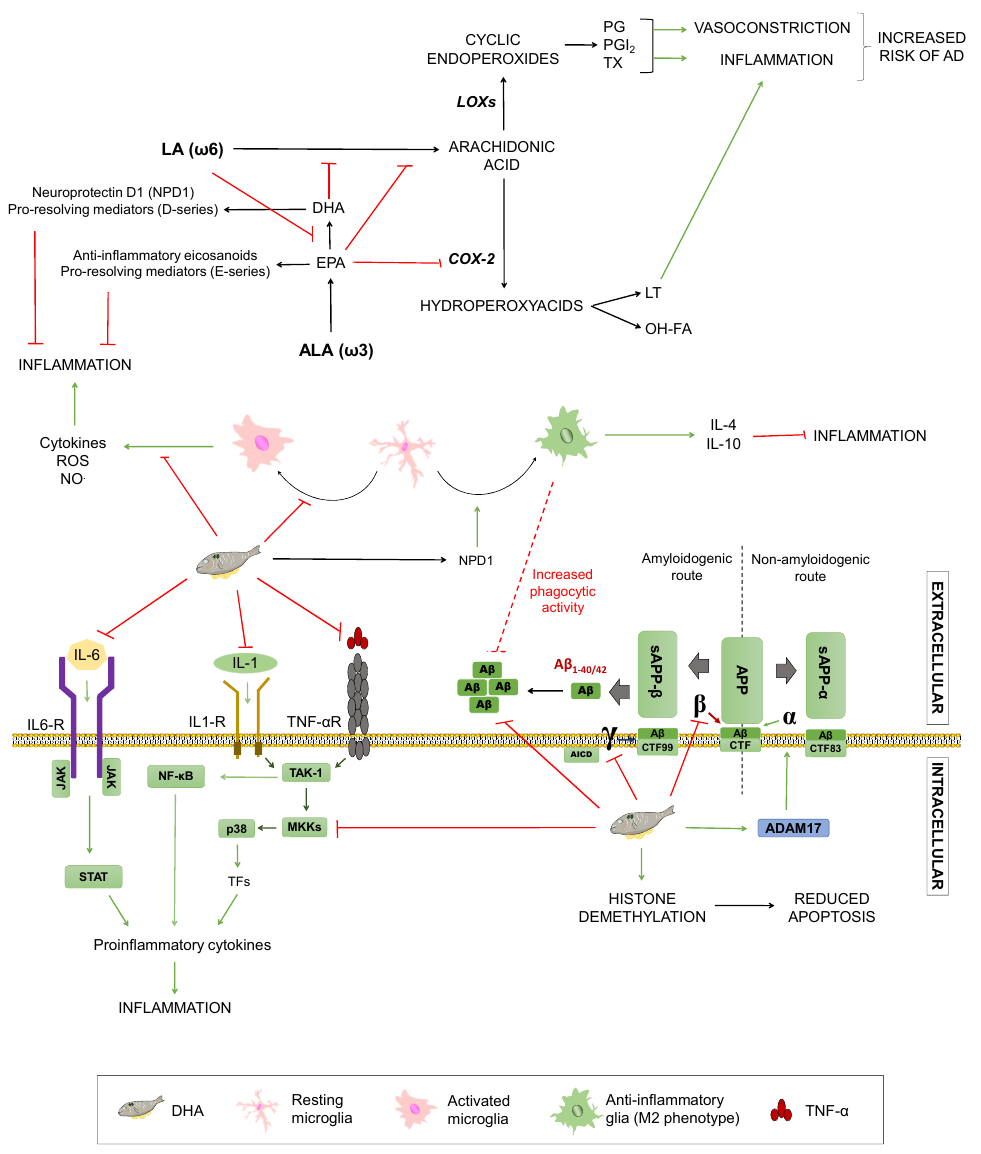
Figure 4. Effects of unsaturated fats on Alzheimer’s disease. Summary of the processes by which unsaturated fats may modulate Alzheimer’s Disease. COX-2: Ciclooxygenase-2. LOXs: